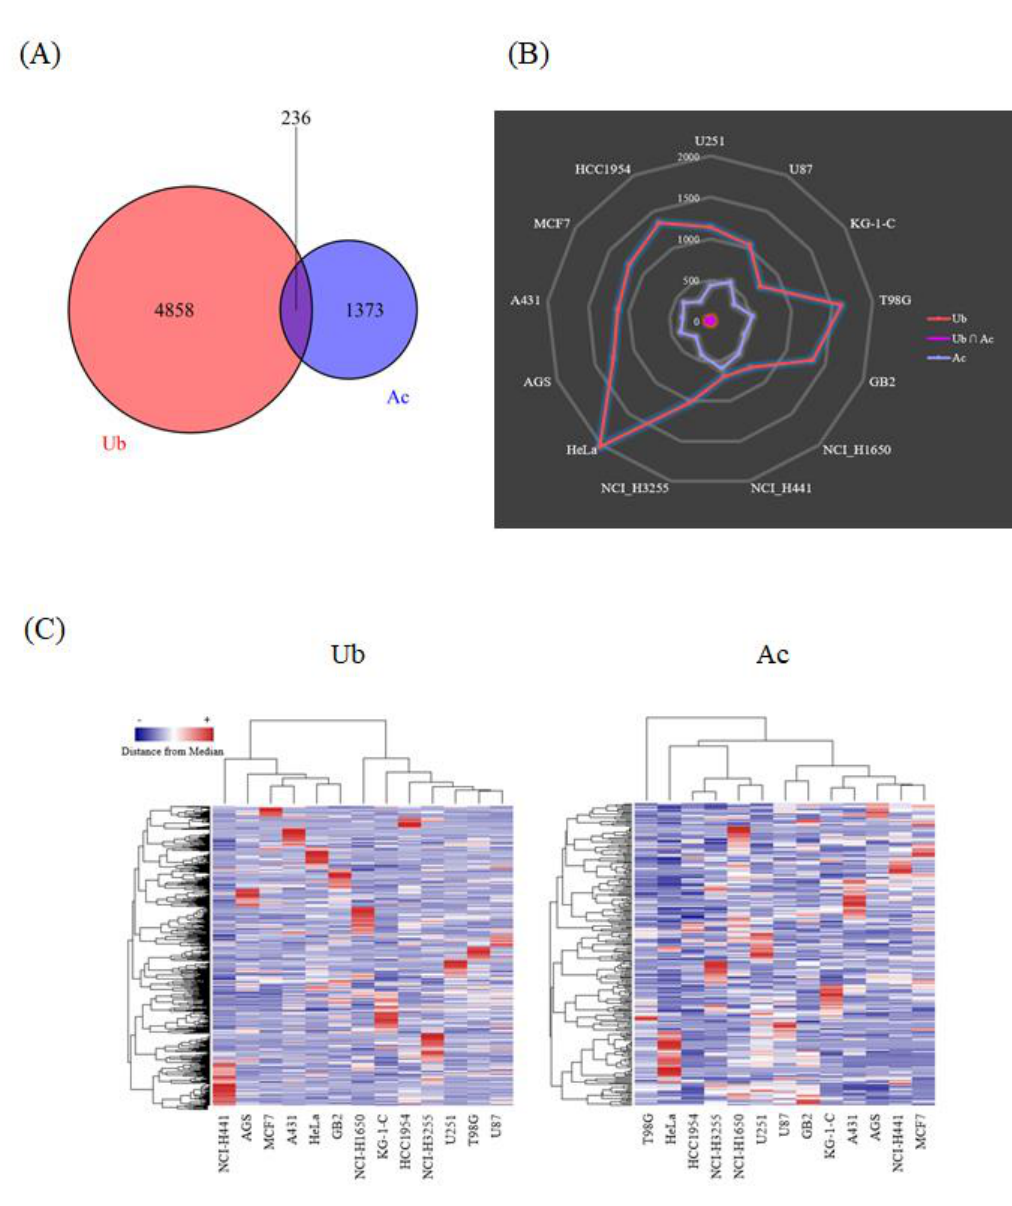
Figure 2. Summary of the ubiquitination and acetylation proteome data on human cancer cells. ( A ) The Venn diagram for the total number of the identified peptides with ubiquitinated / acetylated amino acid residues from all of the cancer cell lines analyzed in this study. ( B ) The radar chart for the comparative distribution of the ubiquitinated and / or acetylated peptides detected from each human cancer cell line. ( C ) The heat map for the hierarchical clustering of the ubiquitination and acetylation proteome data on thirteen human cancer cell lines. The clustered columns on the y -axis indicate the respective modification sites identified in our high-resolution proteomic analysis.